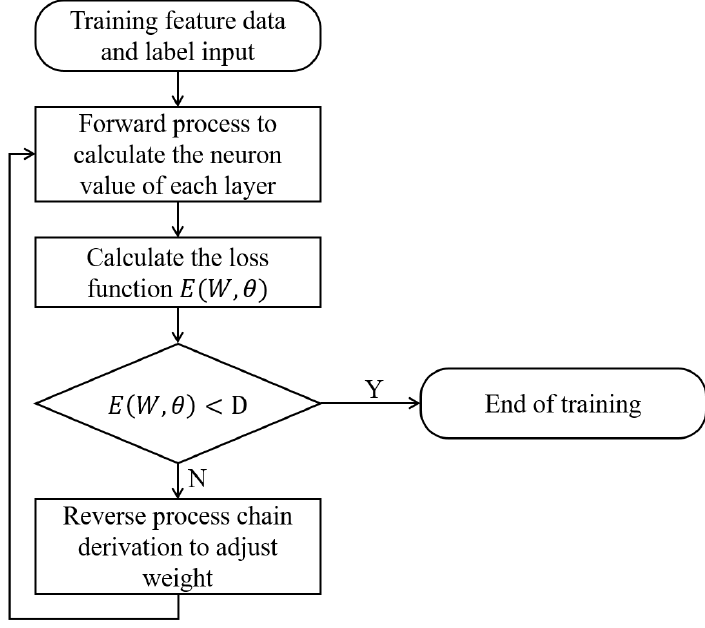
Figure 9. BP neural network algorithm flow chart.